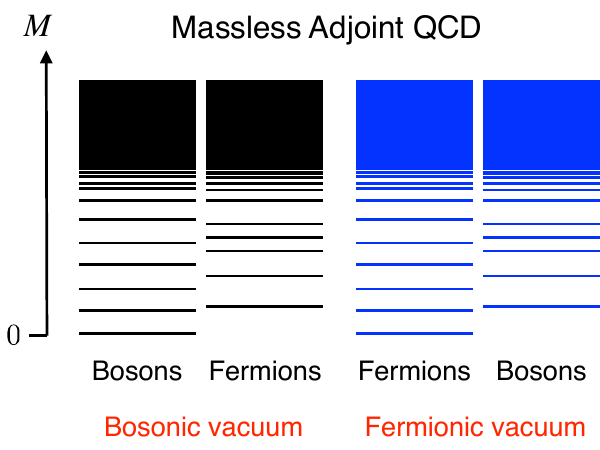
Figure 4: Sketch of the spectrum of 2d massless adjoint QCD with even N on (cid:82) × S 1 . The theory has two vacua with opposite fermion parity. These vacua remain degen- erate even at finite volume due to the ’t Hooft anomaly involving ( (cid:90) Hilbert spaces built using either one of these vacua exhibit a very powerful conspiracy involving the masses of bosonic and fermionic states. They are not paired energy- level by energy-level, but their overall distribution is such that there is no Hagedorn scaling in the ( − 1 ) F -graded density of